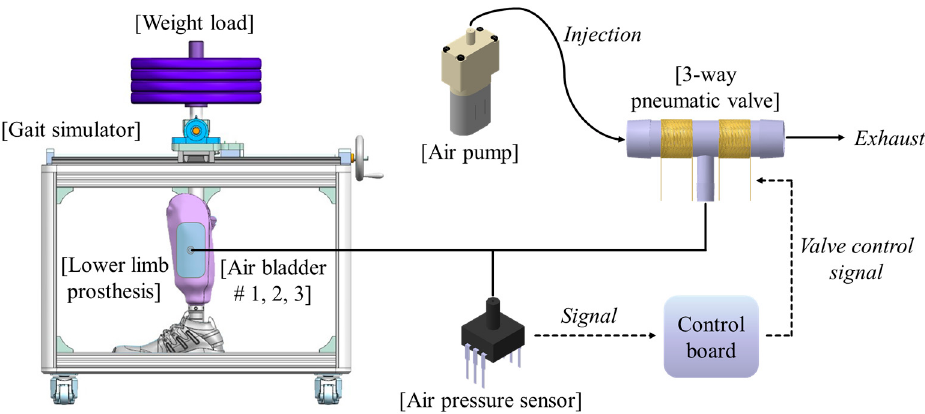
Figure 2. The conceptual diagram of the proposed socket system to actively compensate for the volume change in residual limb.